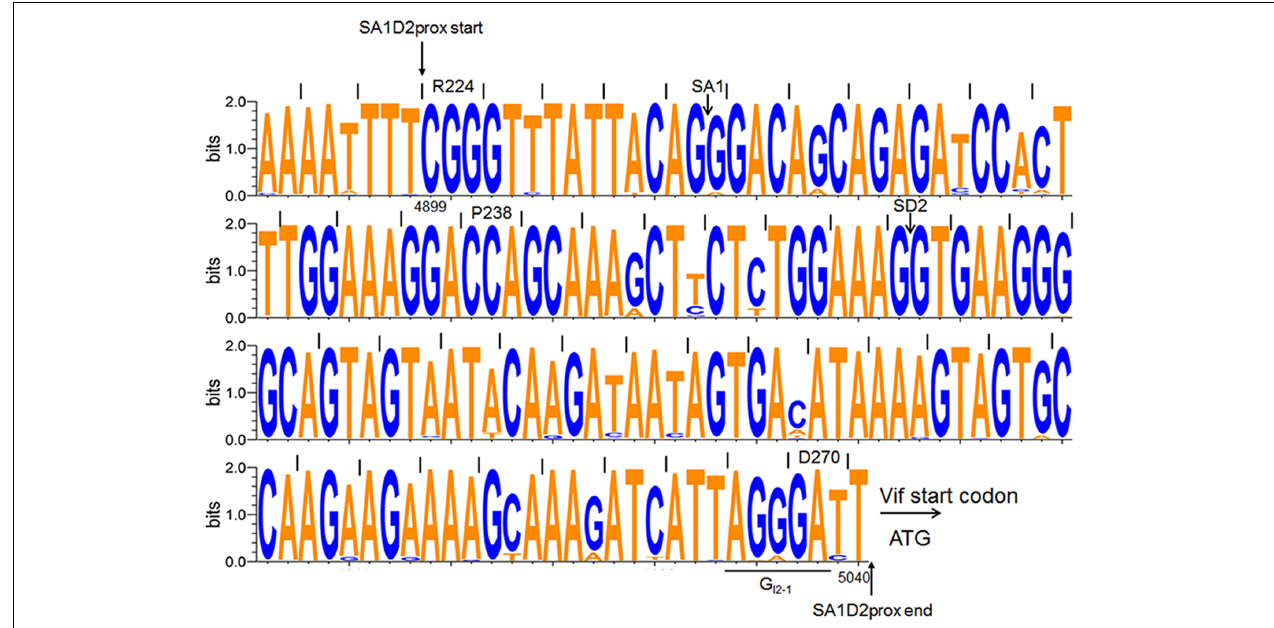
FIGURE 2 | Sequence alignment of SA1D2prox among HIV-1 subtype B viruses. Nucleotide sequence logo was created by WebLogo3 software (http://weblogo.threeplusone.com/create.cgi) (Schneider and Stephens, 1990; Crooks et al., 2004). Sequences (2885 sequences corresponding to nucleotides 4891–5040 of HIV-1 NL4-3) of HIV-1 subtype B were obtained from the HIV-1 sequence database (Los Alamos National Laboratory, http://www.hiv.lanl.gov/). Start and end positions of SA1D2prox region, SA1 and SD2 sites, the start codon for Vif, and a splicing regulatory element G I2 -1 are indicated. Amino acids and their numbers of NL4-3 Pol-integrase are shown above the sequence. Numbers below the sequence represent nucleotide numbers of HIV-1 NL4-3.